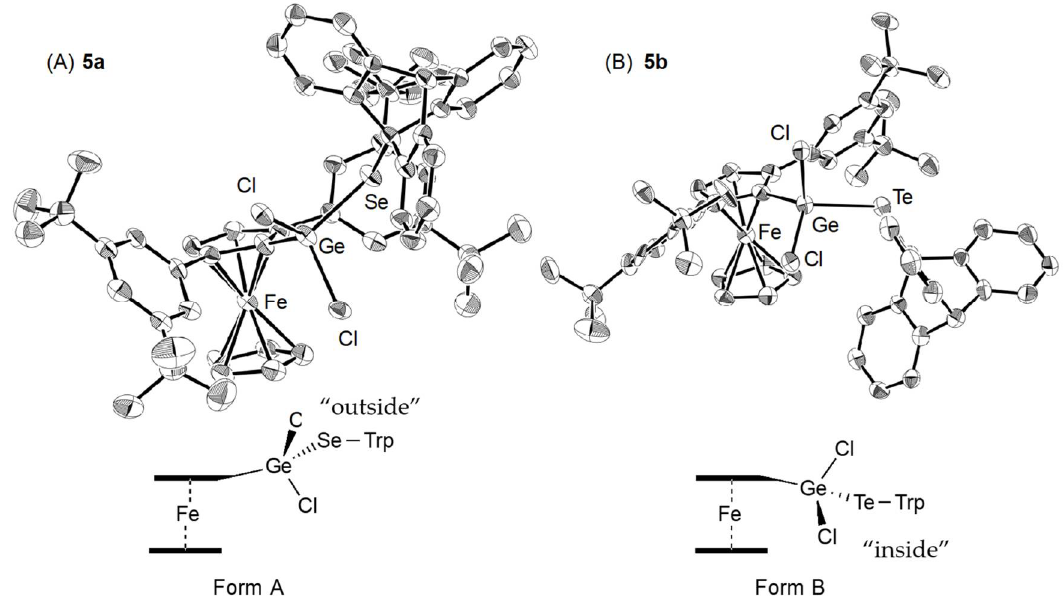
Figure 2. Molecular structures of ( A ) 5a and ( B ) 5b with atomic displacement parameters set at 50% probability. All hydrogen atoms and solvent molecules were omitted for clarity and only selected atoms are labeled.